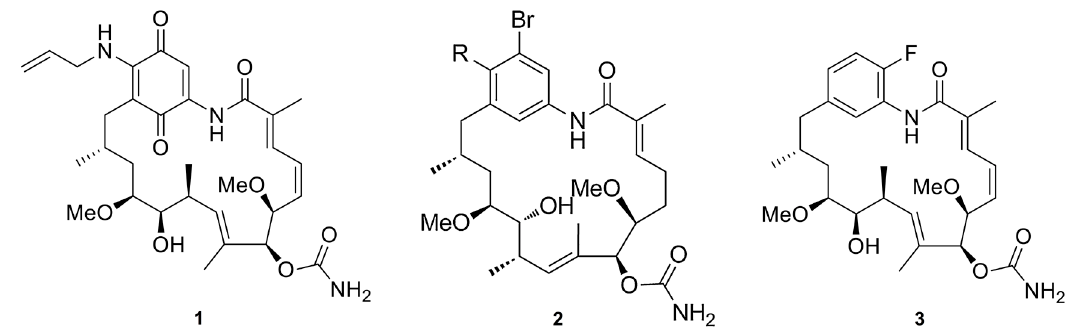
Figure 1. Structures of 17 AAG (1) and the non-quinone geldanamycin bromo-reblastin derivative (2) and 18-dehydrox-19-fluoro-reblastatin